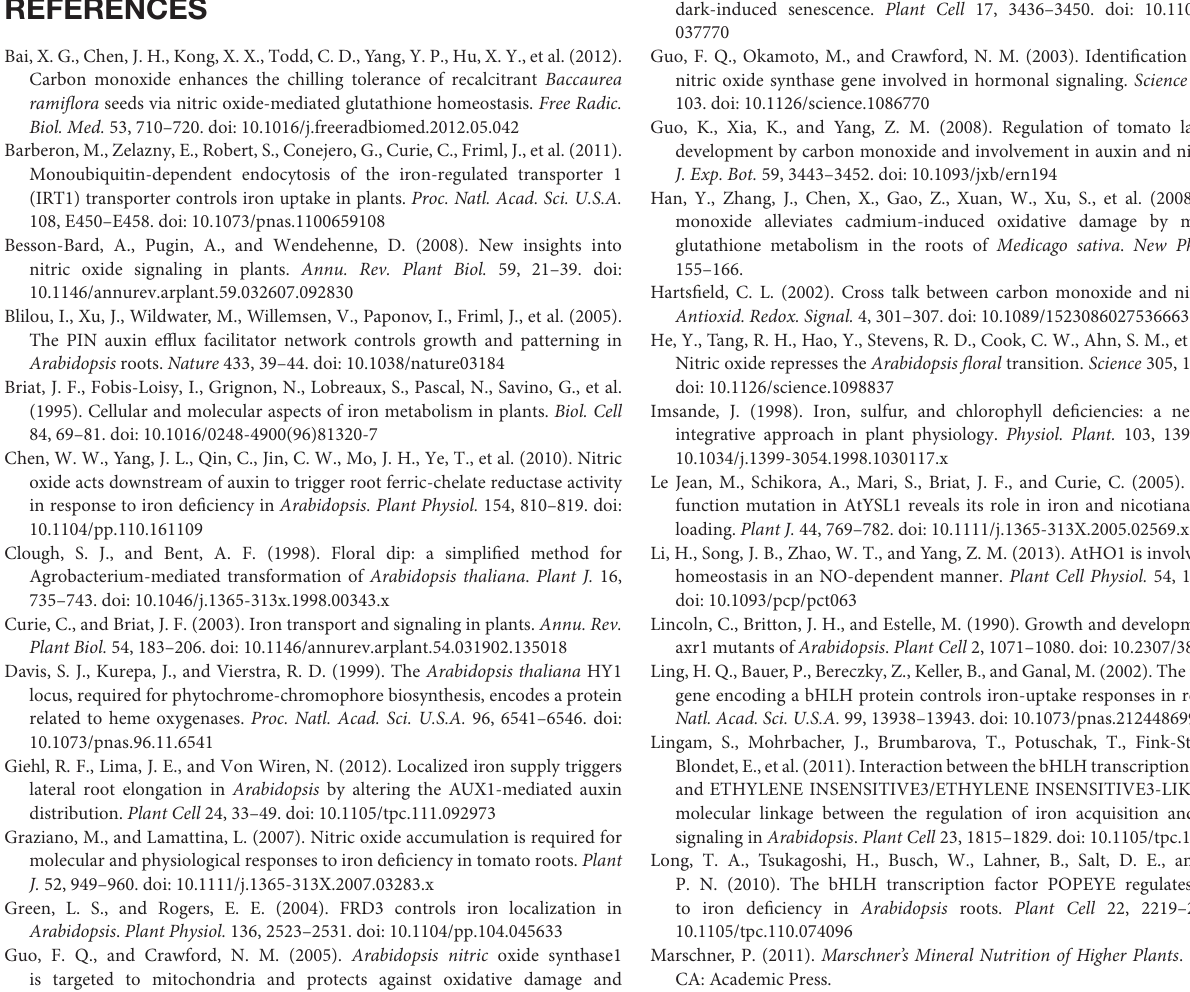
FIGURE S5 | Carbon monoxide (CO) modulates root hair and lateral root development. (A,B) Root hair phenotype of Col-0, hy1 , and HY1-OX lines grown in + Fe, –Fe, and –Fe + CORM2 media for 1 week. (C) Col-0, hy1, and HY1-OX lines grown on + Fe, –Fe, or –Fe + CORM2 media for 1 week. FIGURE S6 | The effects of different inhibitors on FCR activity in the wild-type Col-0 lines with or without –Fe treatment. Two-week-old wild-type-lines were treated with 100 nM NAA, 10 µ M NPA, 200 µ M ZnPPIX, 300 µ M cPTIO, 1 mM L-NAME, 10 mM tungstate, 100 nM CORM2, 100 nM CORM2 + 10 µ M NPA, 30 µ M SNAP, 30 µ M GSNO, and 30 µ M SNAP + 10 µ M NPA, respectively, for 1 week, and the FCR activity was measured. Data are the means ± SD ( n = 12), and bars with different letters are significantly different at p < 0.05 (Tukey’s test). FIGURE S7 | The effects of different inhibitors on auxin transport in the roots of wild-type Col-0 lines with or without –Fe treatment. Two-week-old wild-type Col-0 lines were treated with 100 nM NAA, 10 µ M NPA, 200 µ M ZnPPIX, 300 µ M cPTIO, 1 mM L-NAME, 10 mM tungstate, 100 nM CORM2, 100 nM CORM2 + 10 µ M NPA, 30 µ M SNAP, 30 µ M GSNO, and 30 µ M SNAP + 10 µ M NPA, respectively, for 1 week, and basipetal auxin transport was measured. Data are the means ± SD ( n = 9), and bars with different letters are significantly different at p < 0.05 (Tukey’s test).